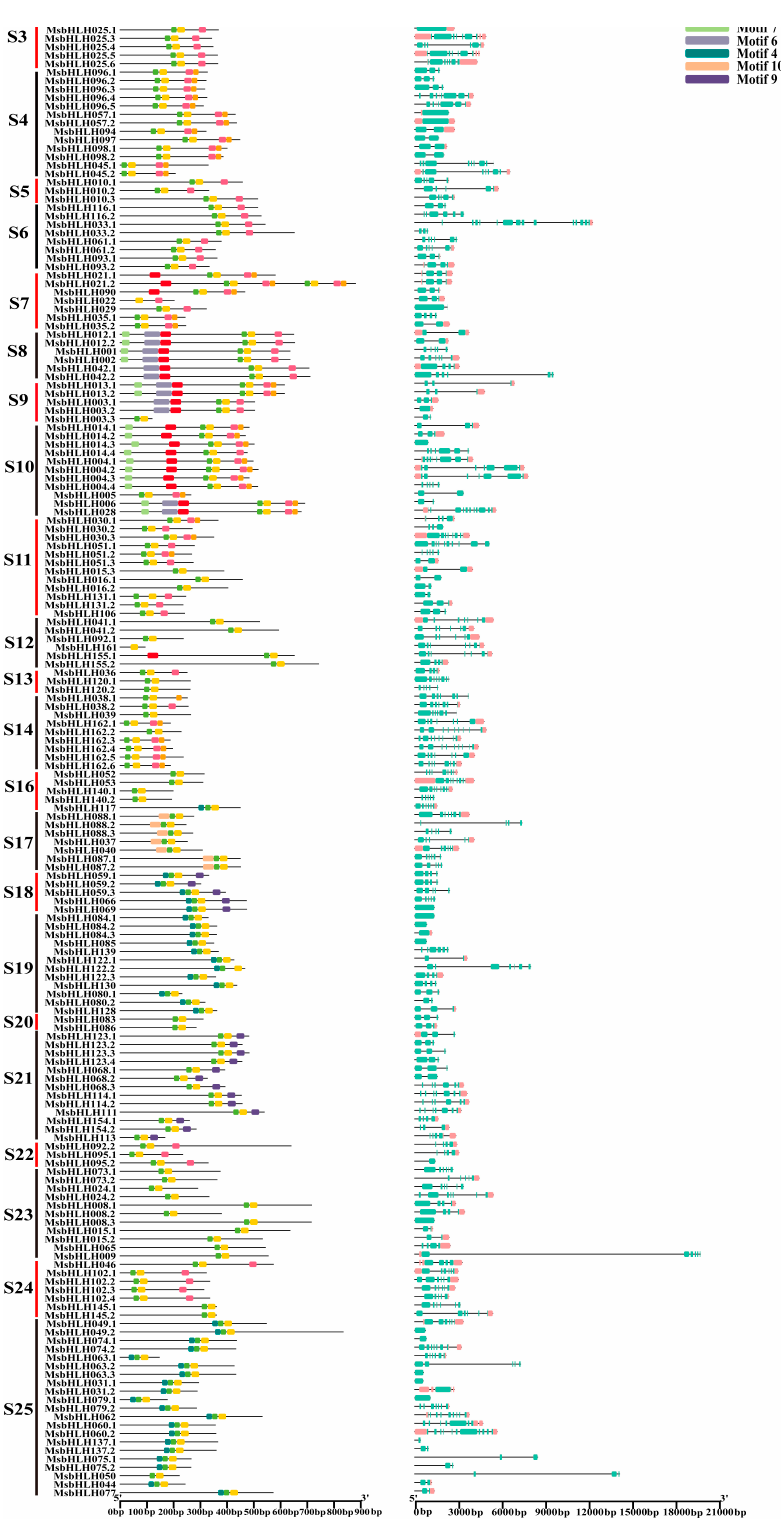
Figure 3. Conserved motif types and distributions in putative MsbHLH proteins. A: Conserved motif analysis of the M. sieversii bHLH family. The conserved motifs were identified using MEME software with the following parameters: maximum number of motifs with 10, optimum motif width of 8 to 50, and other settings as defaults. B: Gene structure of the M. sieversii bHLH family. The intron–exon structure was obtained based on the gene annotation file of the M. sieversii genome and visualized using the TBtools. S2–S25 represent subfamily 2–subfamily 25.